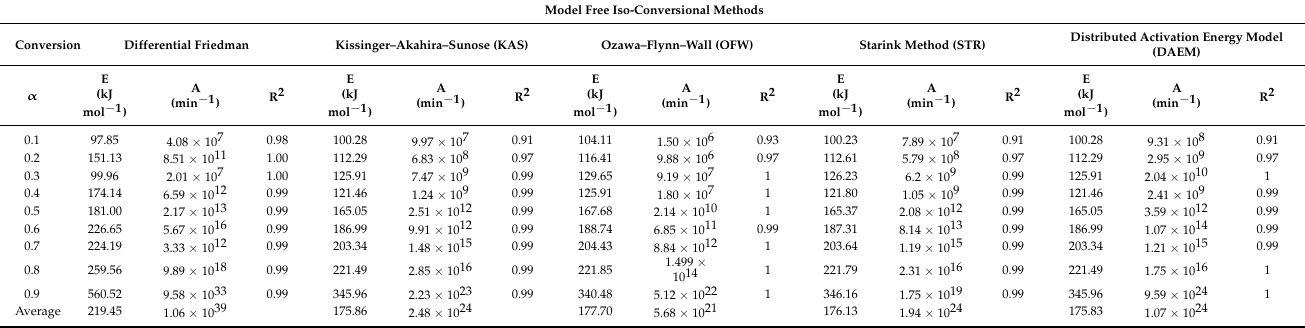
Table 5. Activation Energy and the pre-exponential factors for the co-pyrolysis of the groundnut de-oiled cake and plastic